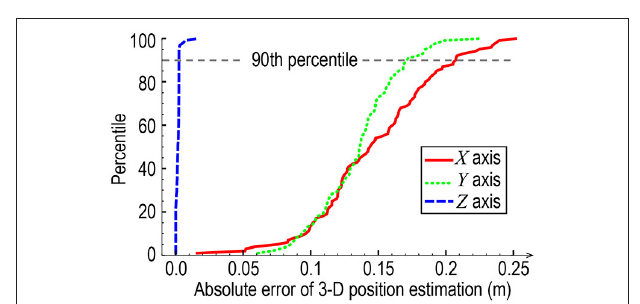
FIGURE 17 | Absolute errors in the 3-D coordinates using nine P F